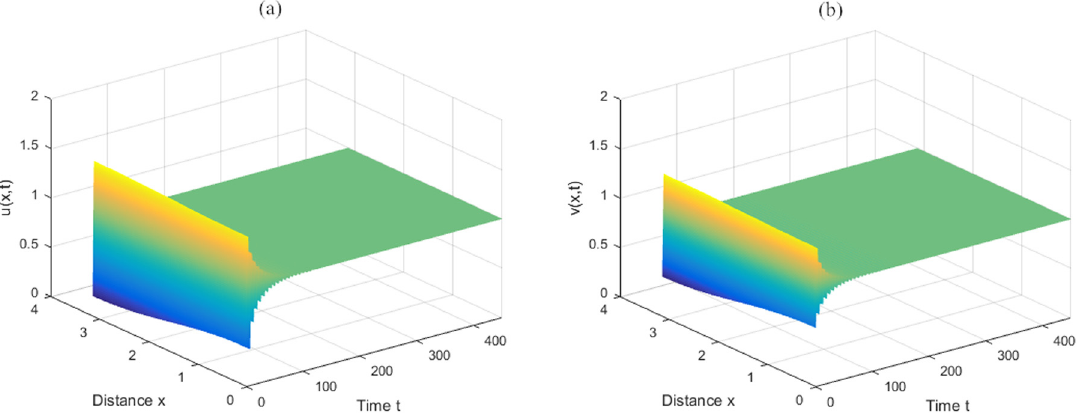
Figure 2: The positive equilibrium E ∗ of system ( 4.43 ) is locally asymptotically stable in the u x t − − space and v x t − − space, respectively.